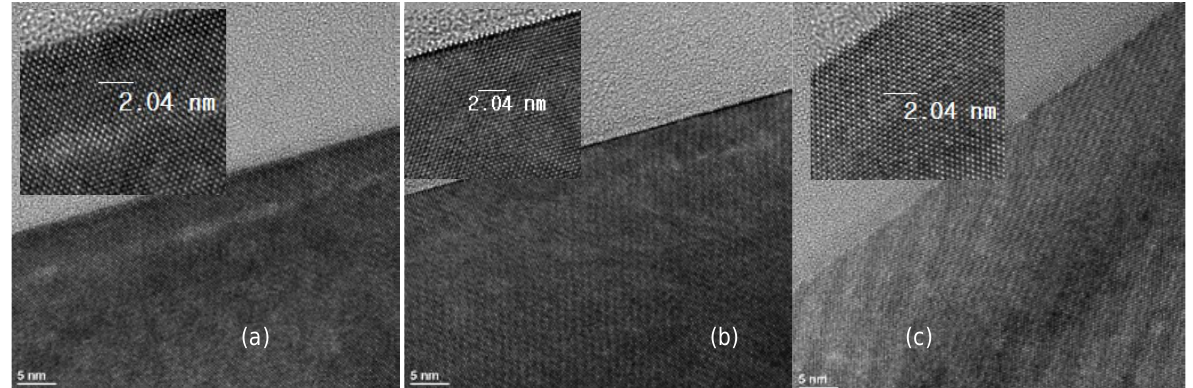
Figure 4. The TEM images of the Si epitaxial films obtained after ex-situ pre-cleaning with inset of HRTEM image ( a ) with 1:200 DHF (wet clean only), ( b ) dry clean only, and ( c ) wet + dry cleaning.